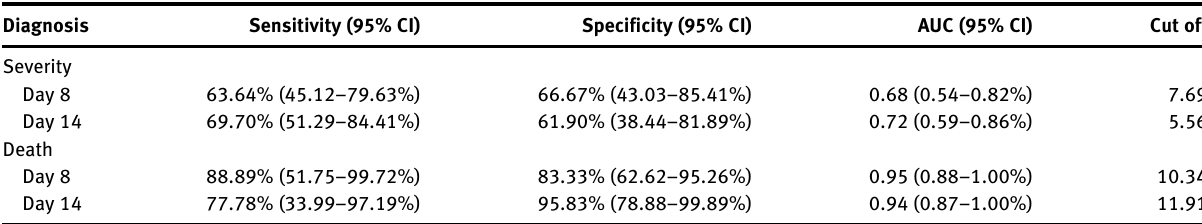
Table  : Diagnosis performance of serum neopterin as biomarker for acute pancreatitis severity and death prediction. Diagnosis